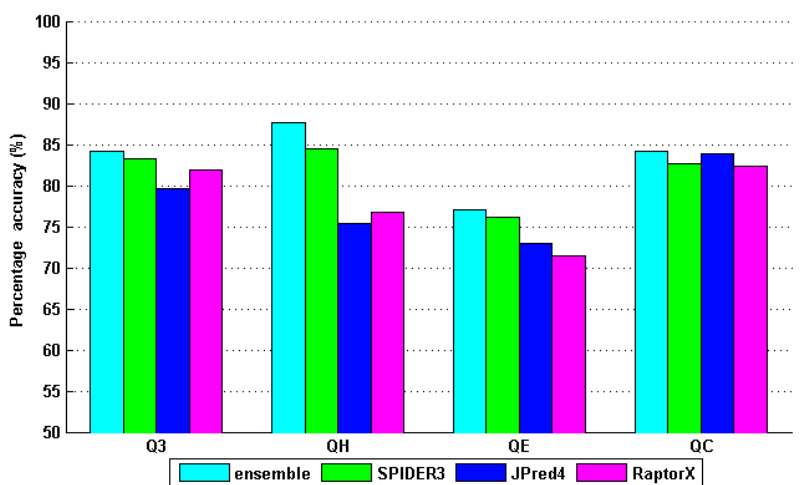
Figure 4. 𝑄 (cid:2871) accuracy of ensemble model and other three methods for 513 protein Cuff & Barton set